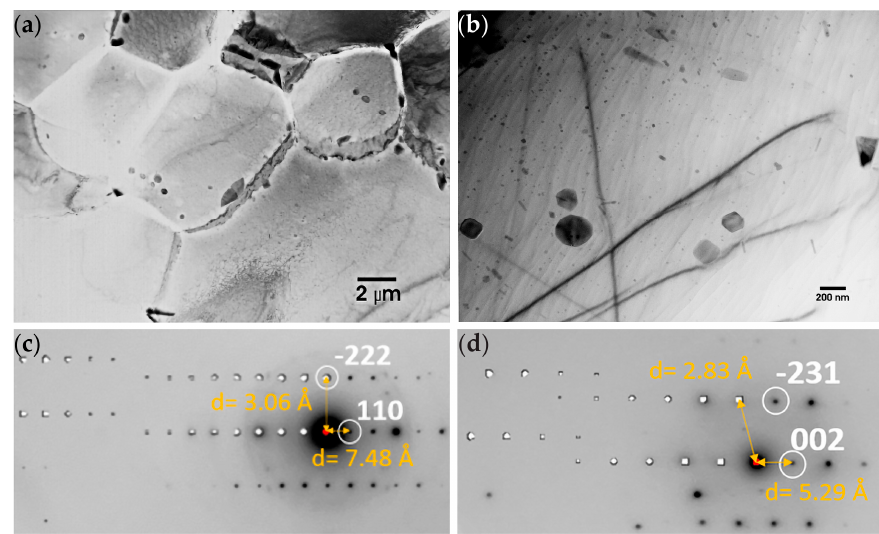
Figure 5. TEM images of alloy AZ61: ( a ) Grains with clearly etched grain boundaries; ( b ) Particles of the secondary phase identified as Mg 17 Al 12 inside a Mg grain; ( c ) [1 − 12] and ( d ) [320] SAD ZA patterns with corresponding simulated patterns indexed in agreement with Mg 17 Al 12 .